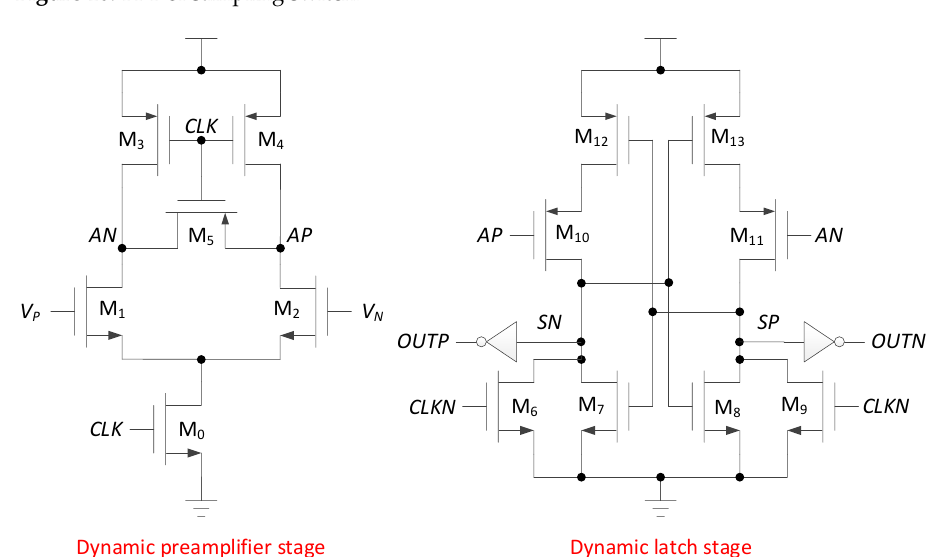
Figure 10. FFT of sampling switch.